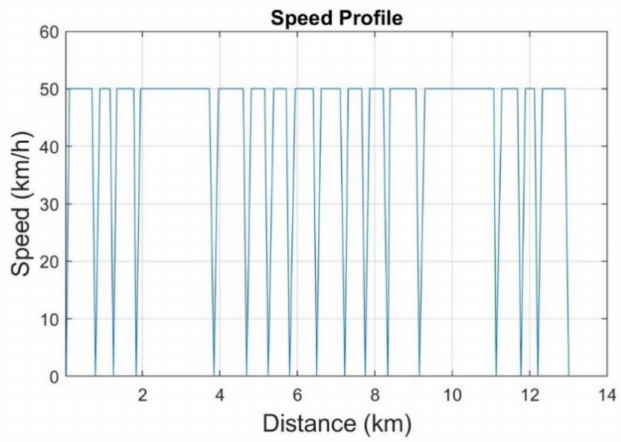
Figure 12. Speed profile of this vehicle vs.